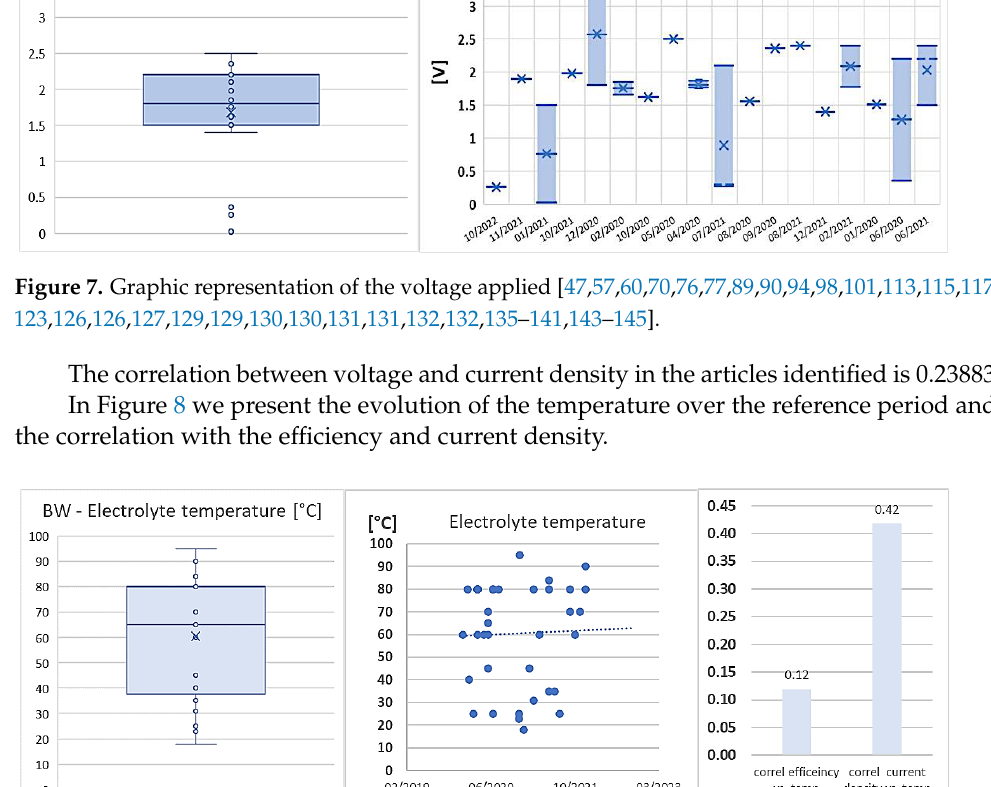
Figure 7. Graphic representation of the voltage applied [47,57,60,70,76,77,89,90,94,98,101,113,115,117,123,126,129 – 132,126,127,129 – 132,135 – 141,143,144,145].